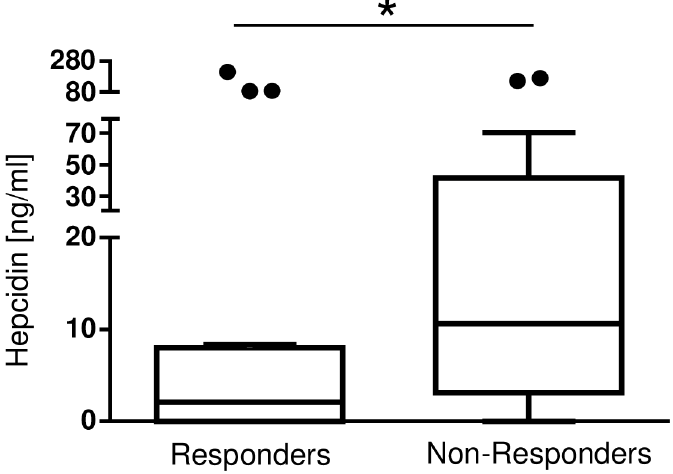
Fig 4. Comparison of hepcidin levels in the groups of responders and non-responders. Serum hepcidin levels were lower in anemic patients with a good response to IV iron (2.07ng/ml [0.25, 7.97], n = 19) compared to anemic patients with an impaired response (10.62ng/ml [3.93, 34.77], n = 21; (cid:3) p = 0.04).